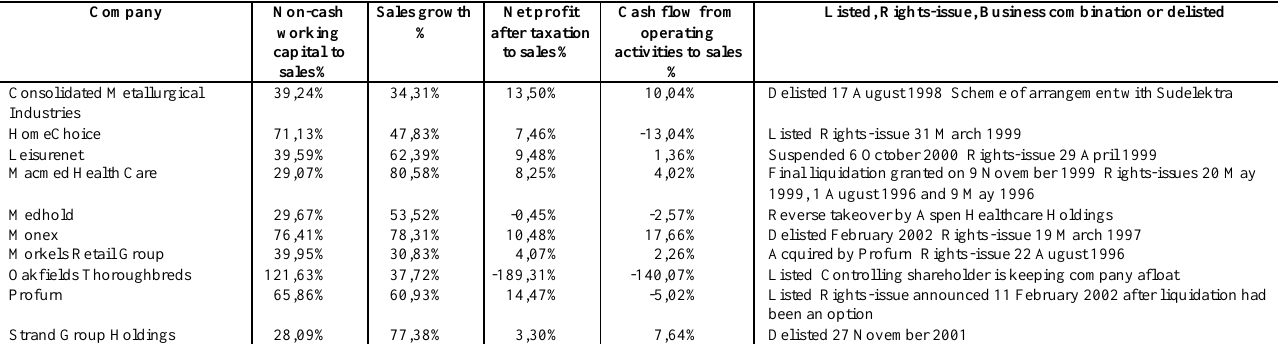
Table 3: Companies in the top quintile of high growth as well as non-cash working capital on average for a five -year